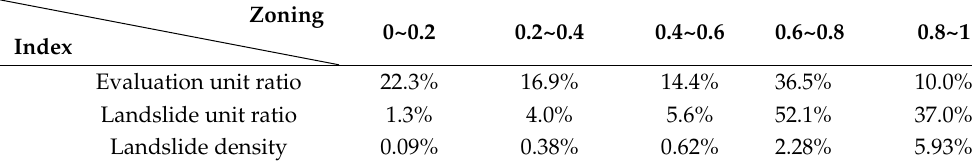
Table 5. Landslide susceptibility zoning based on the LSGH-Net model.